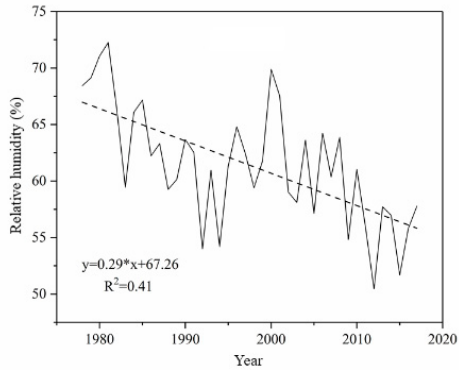
Figure 17. Trends in humidity from 1968–2017 in the Nzhelele and Levuvhu river catchments.